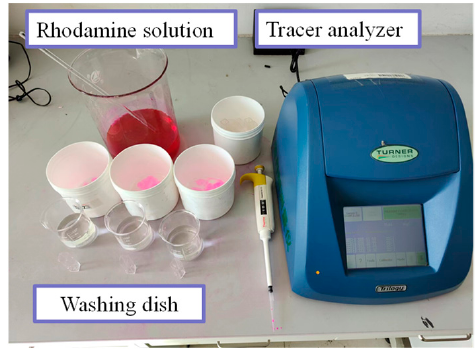
Figure 15. Test instrument.